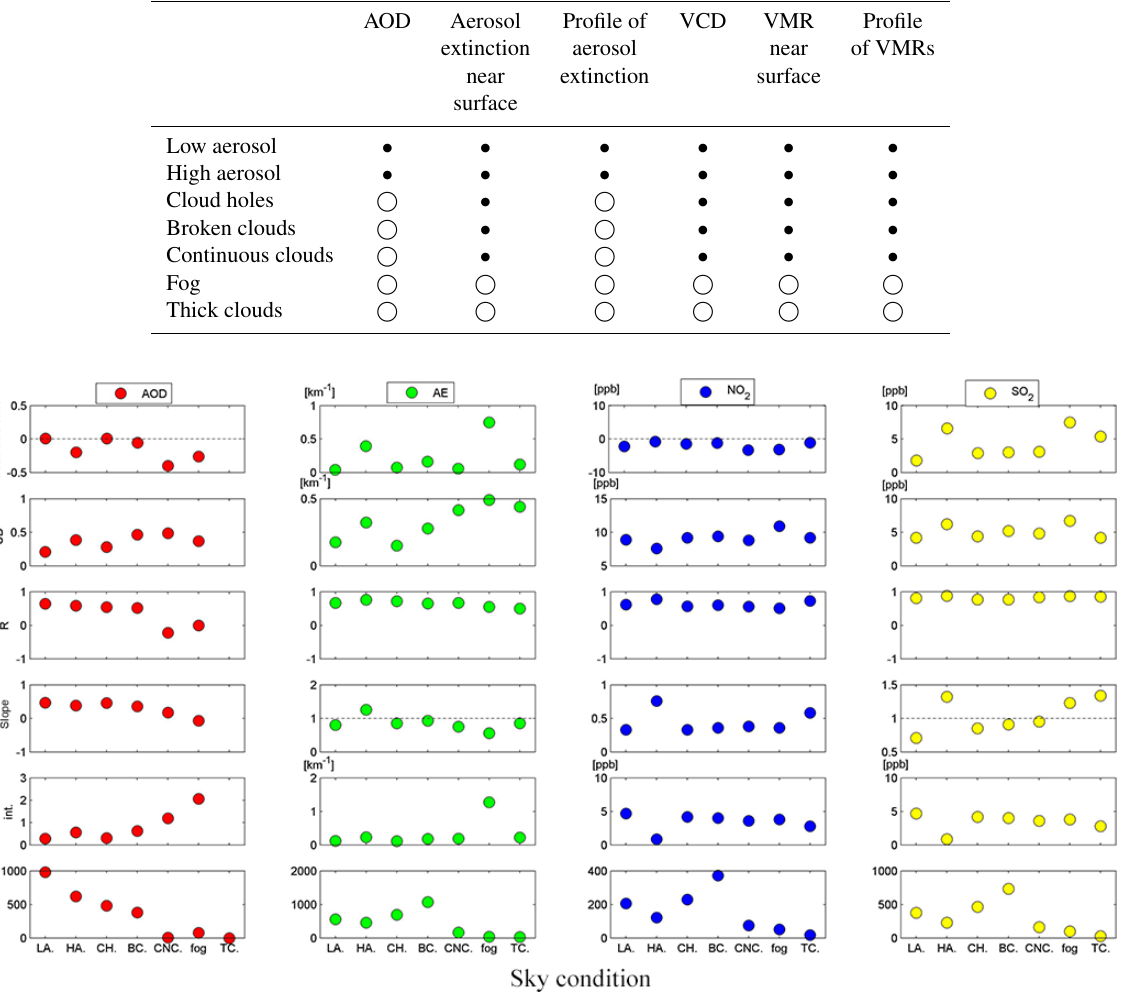
Figure 9. Mean absolute differences and standard deviations as well as correlation coefficients ( R ), slopes and intercepts derived from linear regressions of the AODs, and near-surface AE, NO 2 and SO 2 VMRs between MAX-DOAS and independent techniques for different sky conditions in autumn. The corresponding number of data points is shown in the bottom panel. Different colours denote AOD (compared with the Taihu AERONET level 1.5 data sets), AE (compared with the nearby visibility meter) and NO 2 and SO 2 (compared with the nearby long-path DOAS instrument). For calculations of mean absolute differences, the data derived from independent techniques are subtracted from those derived from the MAX-DOAS instrument. The data derived from the MAX-DOAS instrument are plotted against those derived from independent techniques for linear